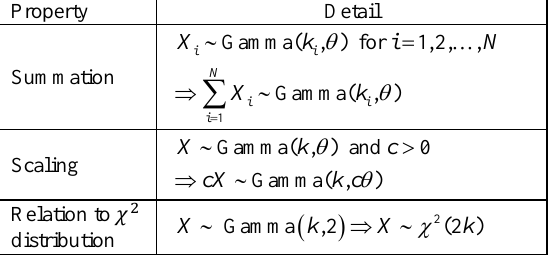
Table 2. Properties of Gamma distribution